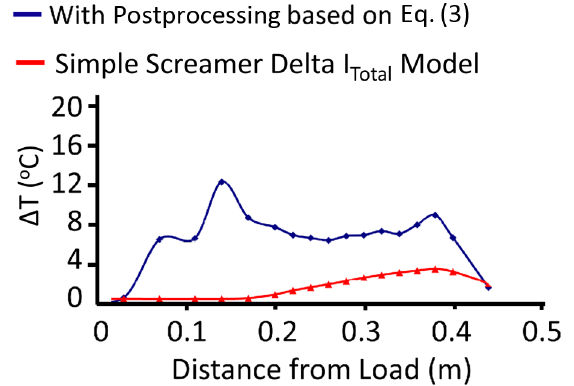
FIG. 9. Computed temperature rise in the anode of the MITE tapered convolute from the Screamer MITL model with the postprocessed Z calculation based on Eq. (3) (blue) and Loss without postprocessing